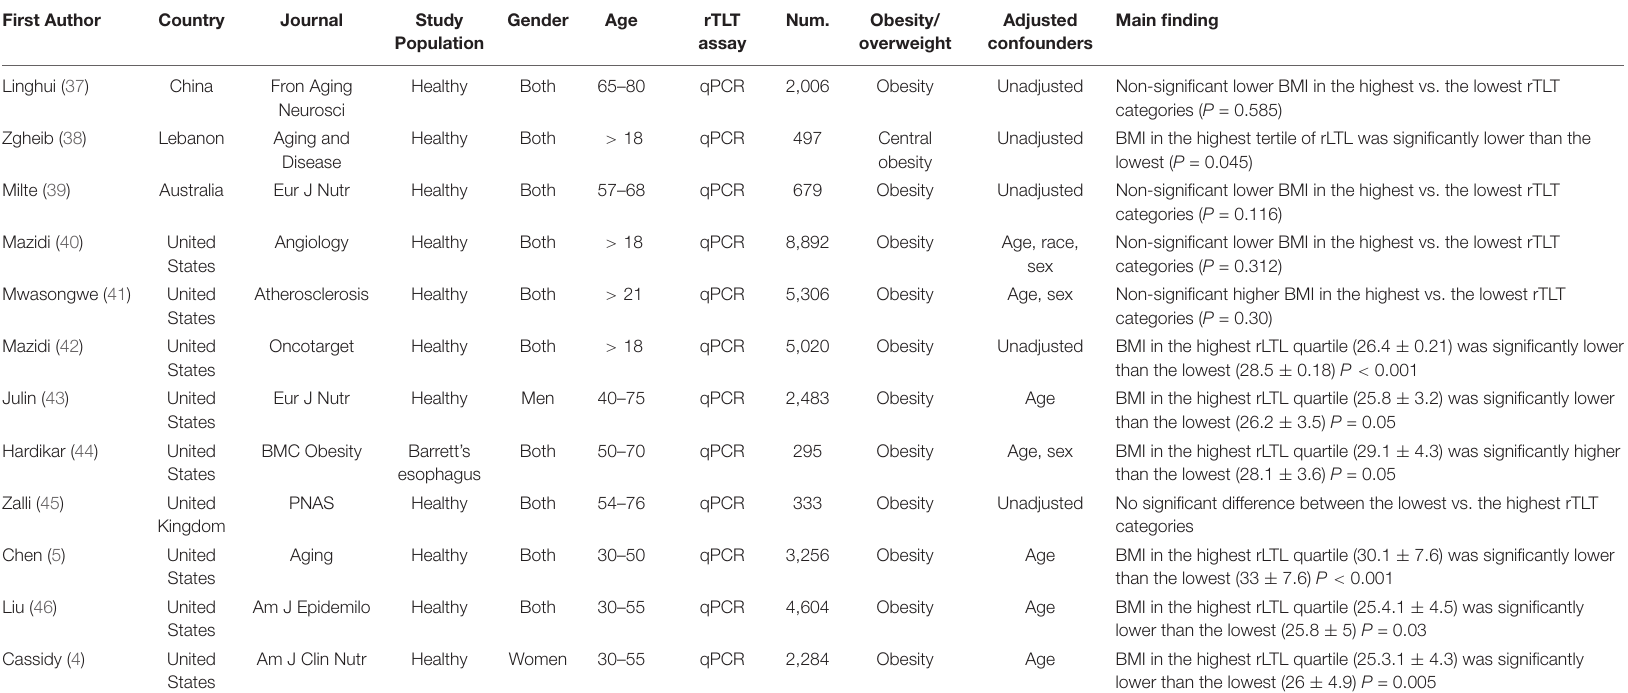
TABLE 1 | Characteristics of studies included in the systematic review owing to report the comparison of BMI between the lowest vs. the highest LTL